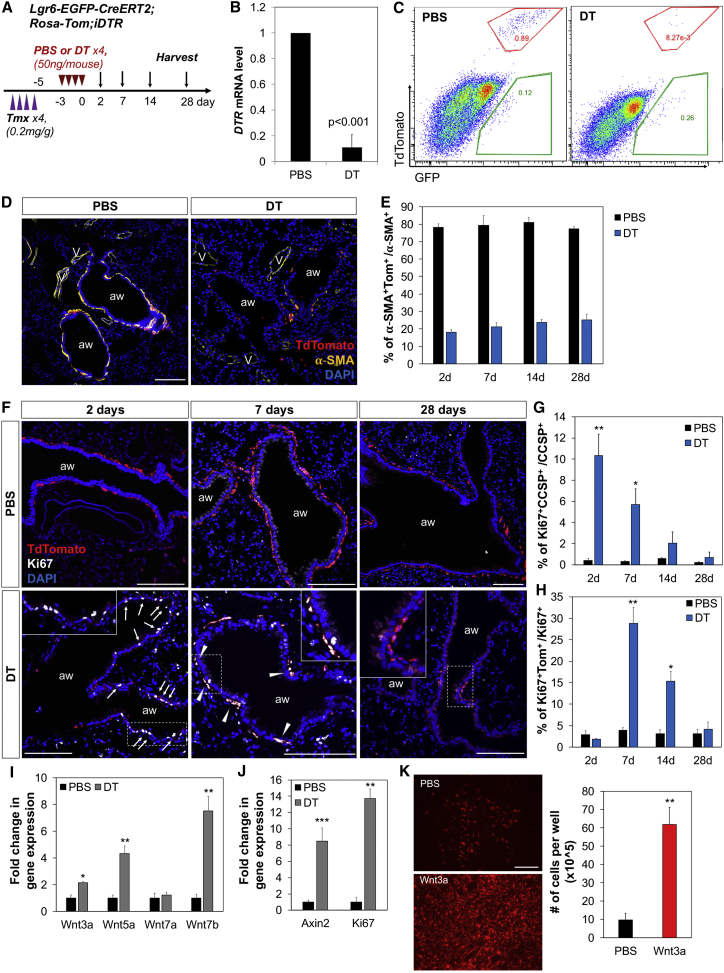
Paired Proliferative Expansion of Lgr6+ Cells and Airway Epithelial Cells after Genetic Ablation of Lgr6+ Cells(A) Schematics of the Lgr6-EGFP-CreERT2;R26-Tom lineage-tracing experiment.(B) qPCR analysis for expression of diphtheria toxin receptor (DTR) in whole lungs from PBS- and DT-treated mice. Shown is normalized to Gapdh.(C) Representative flow cytometry analysis showing the efficient ablation of Lgr6+ cells at 2 days after PBS or DT administration. Cells are gated out from CD31−CD45−EpCAM− populations.(D) Representative confocal images showing the specific ablation of ASMCs marked by Lgr6 at 2 days post-PBS or DT administration: Tdtomato (red); α-SMA (yellow); and DAPI (blue).(E) Graphs to show the mean percentage of lineage-labeled Lgr6+ cells that express α-SMA at indicated time points after PBS (black bars) or DT (blue bars) treatment.(F) Representative confocal images showing proliferation of airway epithelial cells and lineage-labeled Lgr6+ cells after PBS or DT administration: Tdtomato (red); Ki67 (white); and DAPI (blue). Arrow, Ki67+ airway epithelial cells; arrowhead, Ki67+Lgr6+ cells.(G) Graphs to show the mean percentage of CCSP+Ki67+ cells that express CCSP at indicated time points after PBS (black bars) or DT (blue bars) treatment.(H) Graphs to show the mean percentage of lineage-labeled Lgr6+ cells that express Ki67 at indicated time points after PBS (black bars) or DT (blue bars) treatment.(I and J) qPCR analysis for expression of Wnt ligands in isolated secretory cells (I) and Axin2 and Ki67 in isolated lineage-labeled Lgr6+ cells (J) from PBS-treated (black bar) and DT-treated (gray bar) lungs. Shown is normalized to Gapdh.(K) Representative images of in vitro culture of lineage-labeled Lgr6+ cells with PBS or Wnt3a and quantification of Lgr6+ cell numbers at five days in culture.Data presented are the mean of experiments from three individual mice per group (A, E, and G–J) or the mean of three independent experiments (K). Error bars indicate SD (∗p < 0.01; ∗∗p < 0.005; ∗∗∗p < 0.001). The scale bars represent 100 μm. See also Figure S3.